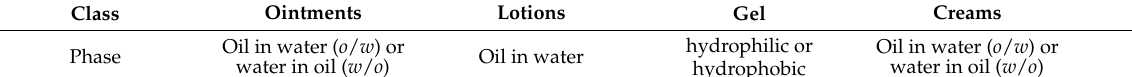
Table 4. Different dispensing formulations of